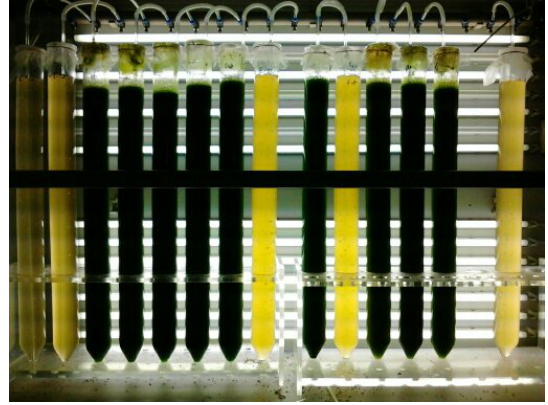
Figure 1. Photo of the vertical tubular